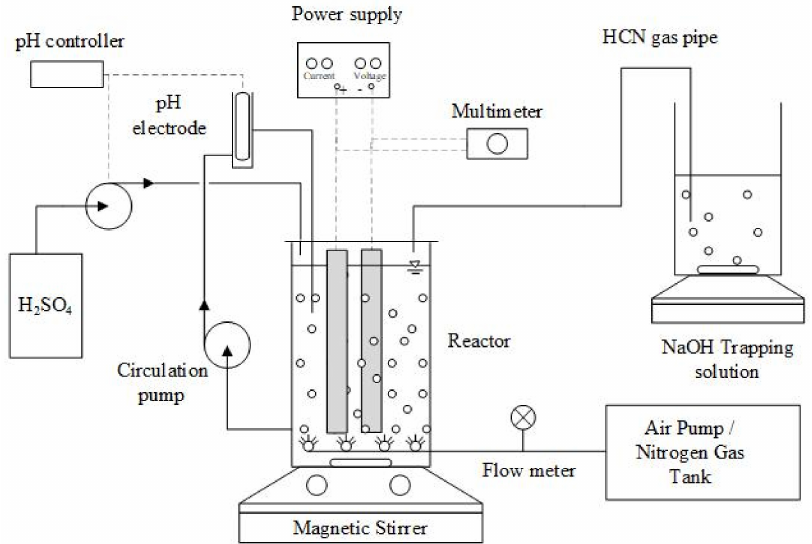
Figure 1. Scheme of the experimental